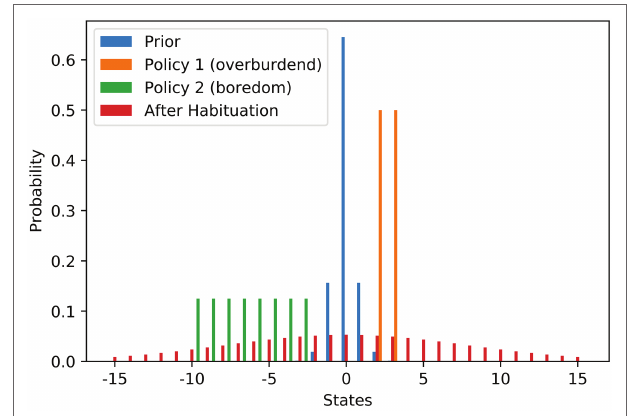
FIGURE 1 | Work stimulus scenario—flattening of probability distributions over goal states underlying stress habituation. The bars show the different probability distributions used in the example of work stimulus preference. The blue distribution is the prior distribution that is encoding the agent’s preferences before habituation. The orange and green distributions visualise the states that can be attained with the two strategies at hand. The orange policy is connected to a scenario of an overwhelming work stimulus, while the green distribution is connected to a scenario of staying in a repetitive and boring job. The red distribution shows the optimal prior distribution the agent would choose if he could optimise its own prior. In our scenario, the red distribution can only be installed as a new prior by